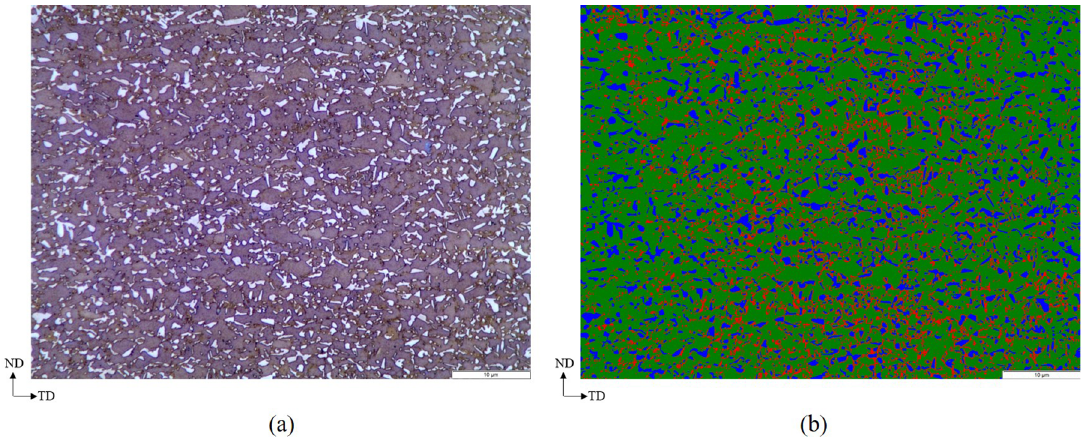
Figure 2. TRIP780 as-received microstructures observed employing light optical microscopy: (a) revealed with LePera etchant (1000X) and (b) from color digital image processing (1000X). (ND – Normal Direction and TD – Transverse